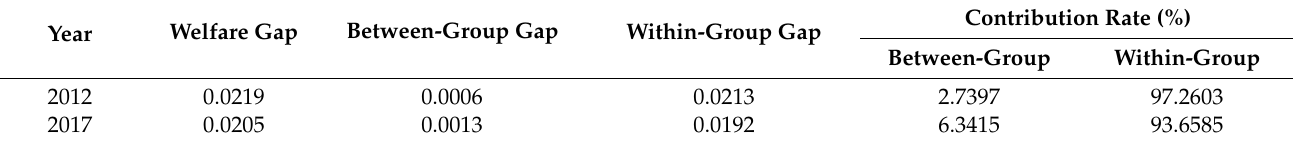
Table 5. Theil index calculation results.